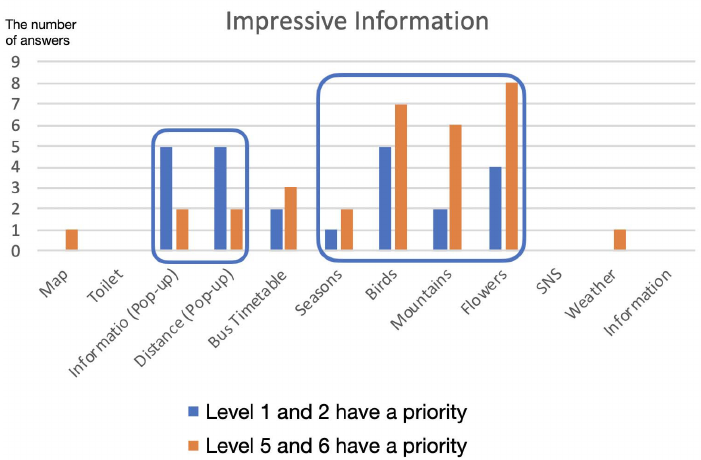
Figure 10. Two different designs of UI: the left one was designed based on layers 1 and 2, and the right one was designed based on layers 5 and